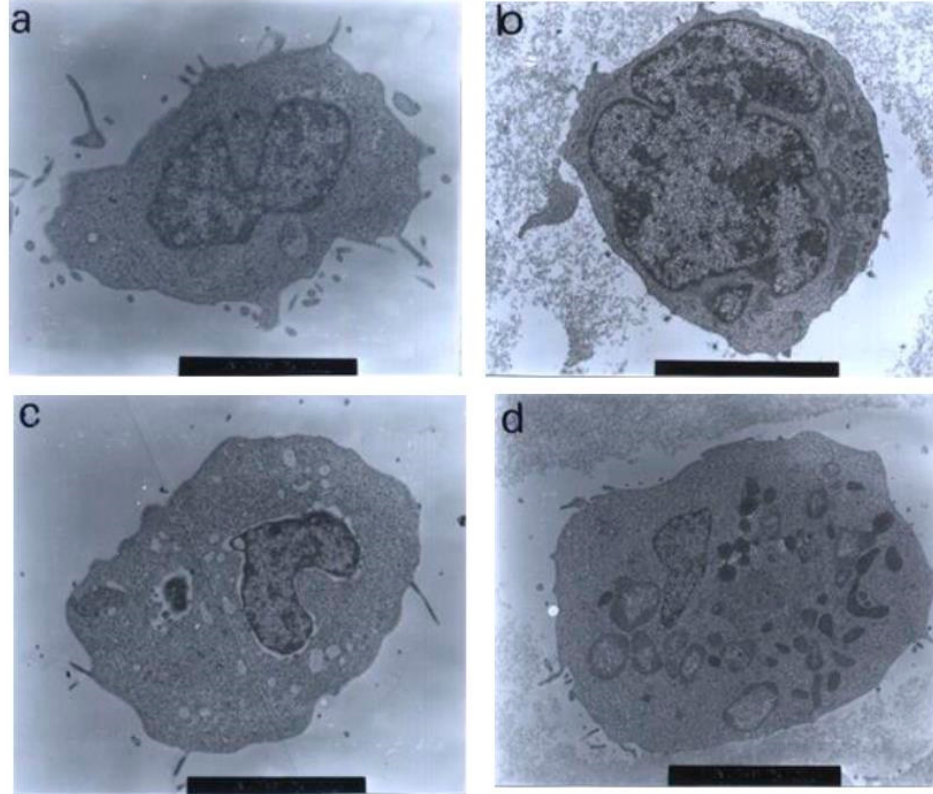
Figure 11. Transmission electron micrographs of CEM-SS cells treated with different concentrations of damnacanthal for 24 h. Cells treated with ( a ) 1 µ g/mL (7000 × magnification), ( b ) 3 µ g/mL (7000 × magnification), ( c ) 10 µ g/mL (5000 × magnification), and ( d ) 30 µ g/mL (6000 × magnification) of dam-